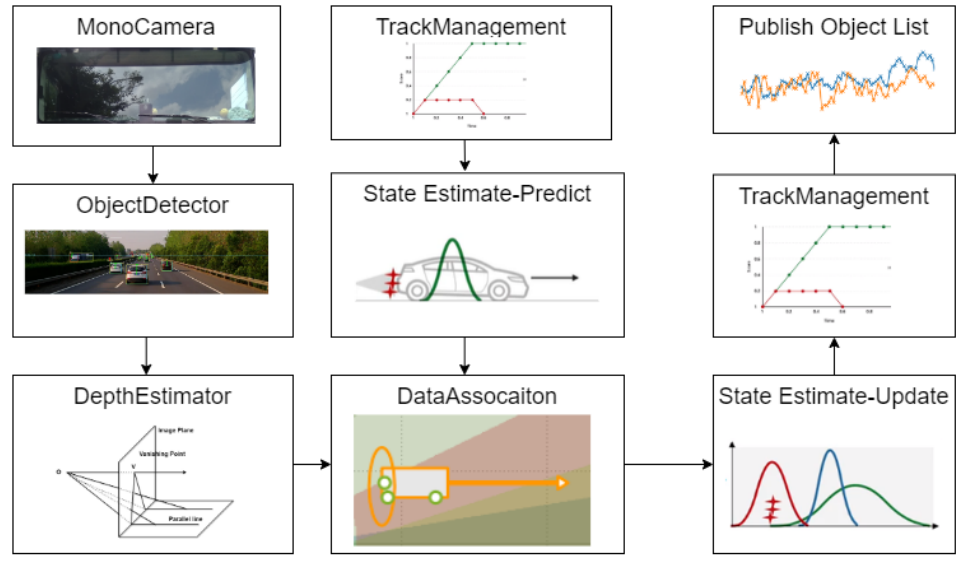
Figure 1. Multi-target tracking system based on mono camera.